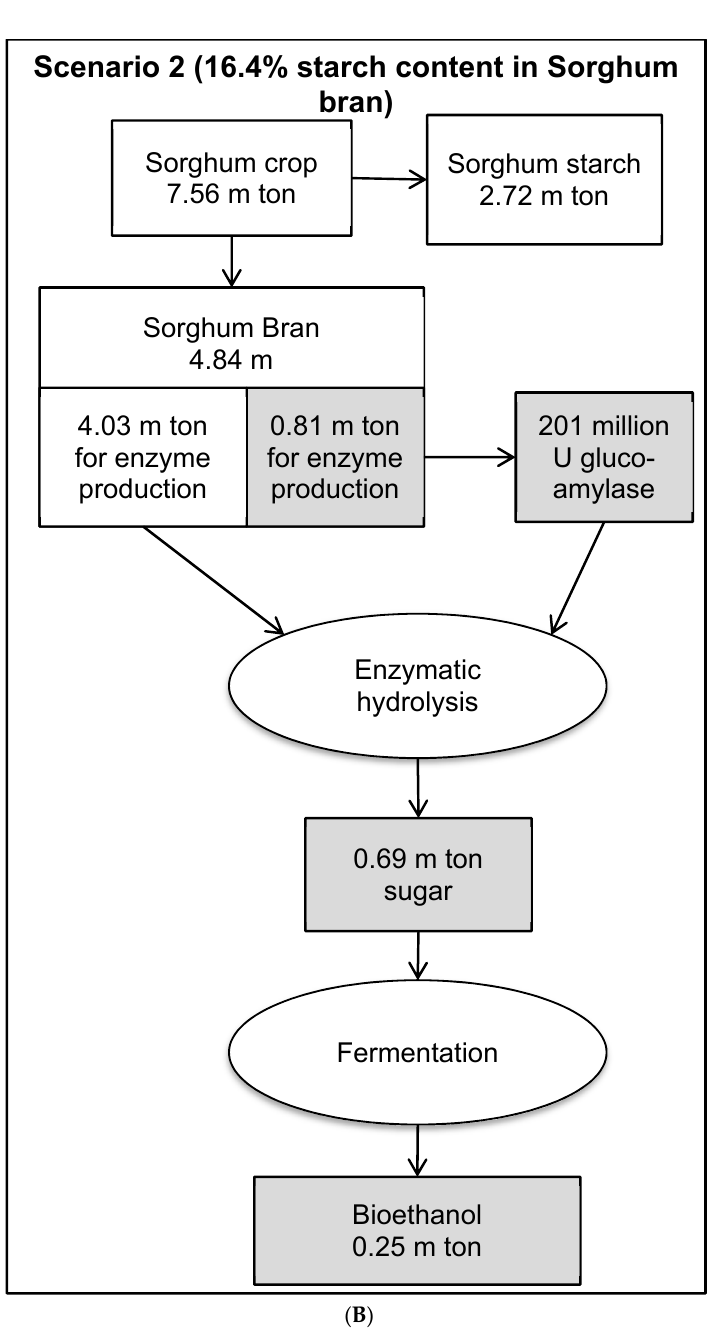
Figure 7. Mass balance of a sorghum bran based biorefining strategy for bioethanol production via glucoamylase hydrolysis process. ( A ): scenario 1, the starch content in sorghum bran was 53% [7]; ( B ) scenario 2, the starch content in sorghum bran was 16.4% (this study).